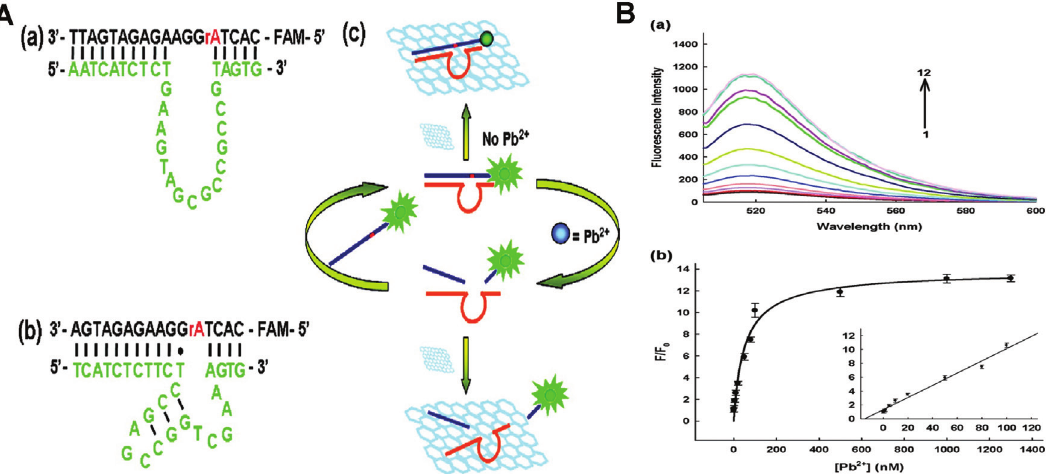
Figure 4 (A): (a) Secondary structure of the GR-5 DNAzyme hybridized with the FAM-labeled substrate strand; (b) secondary structure of the 8–17 DNAzyme hybridized with the FAM-labeled substrate strand; (c) schematic illustration of the DNAzyme_GO based fluorescence sensor for Pb 2+ . (B): (a) Fluorescence emission spectra of the sensing system on exposure to Pb 2+ solutions of different concentrations and then mixed with GO; (b) calibration curve of the sensing system for Pb 2+ . The curve was plotted with thefluorescence enhancement vs Pb 2+ concentration. Inset shows the linear responses at low Pb 2+ concentrations. Reprinted with permission from: Zhao et al. 2011, copyright 2011, American Chemical